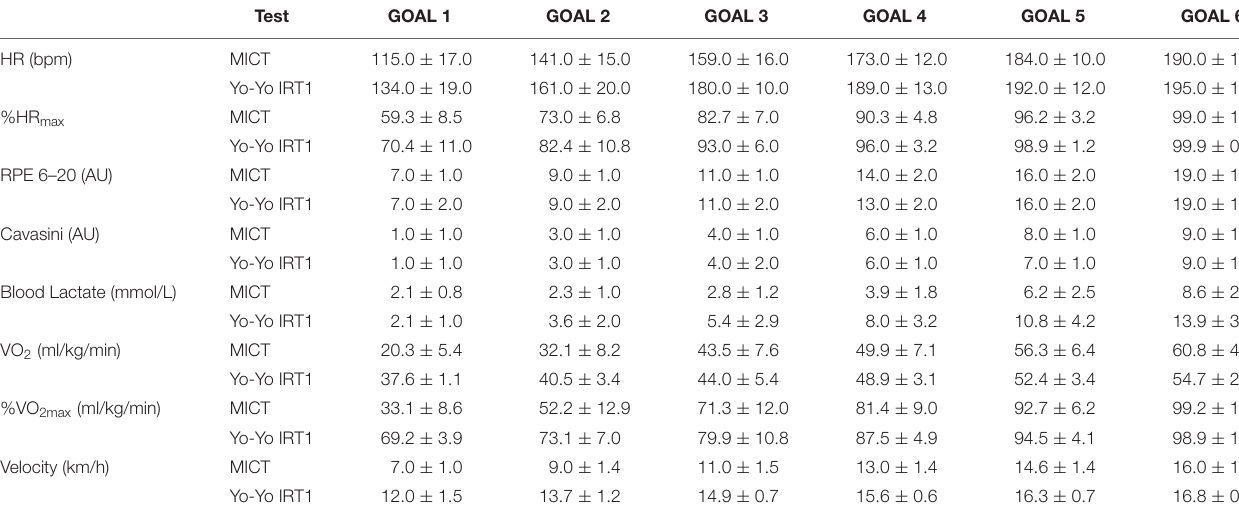
TABLE 1 | Values of psychological and physiological variables during maximal